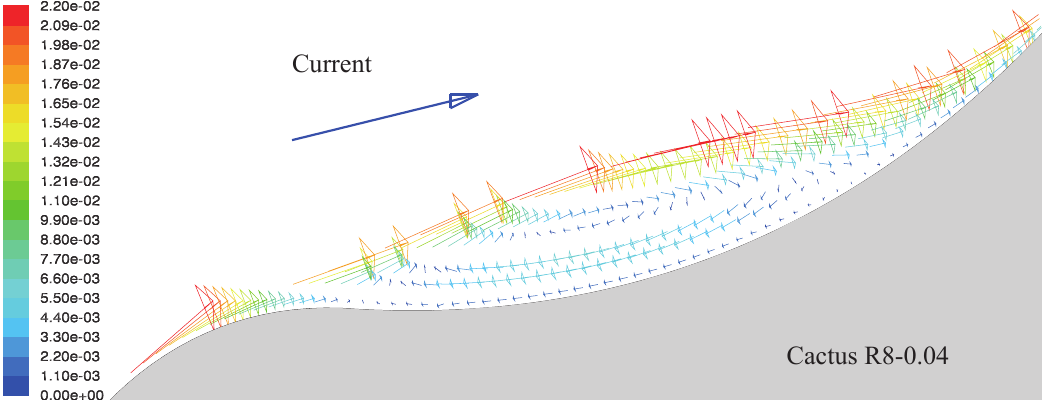
Figure 7. Velocity vectors of current flow near the ridges of cactus-shaped cylinder, R